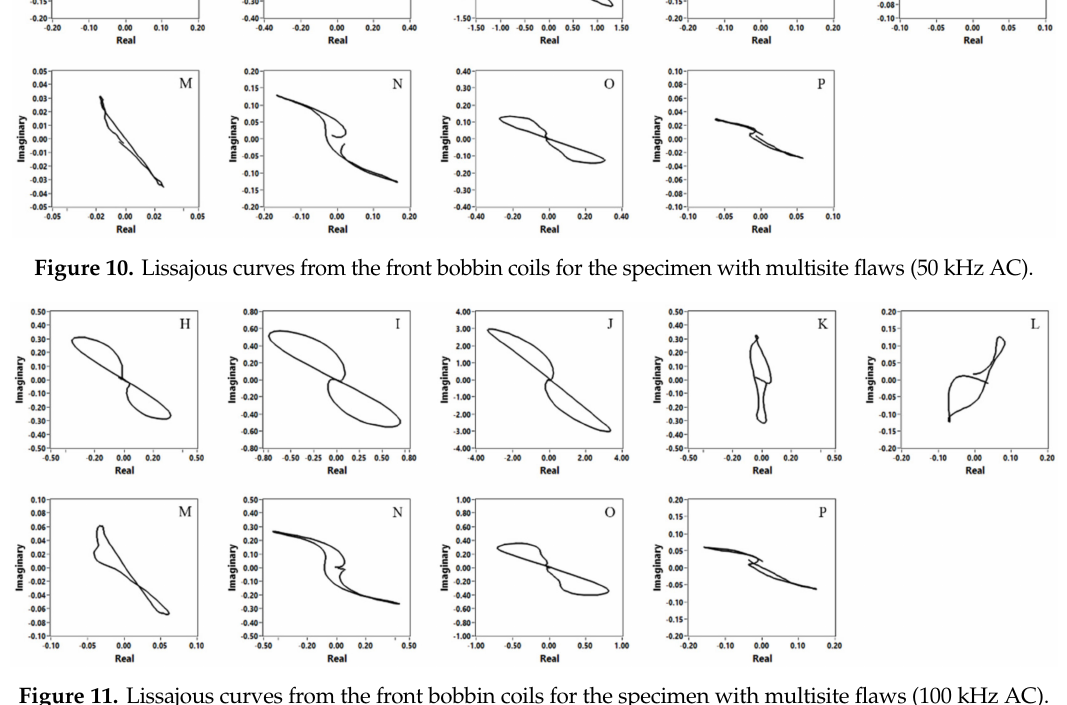
Figure 11. Lissajous curves from the front bobbin coils for the specimen with multisite flaws (100 kHz AC).